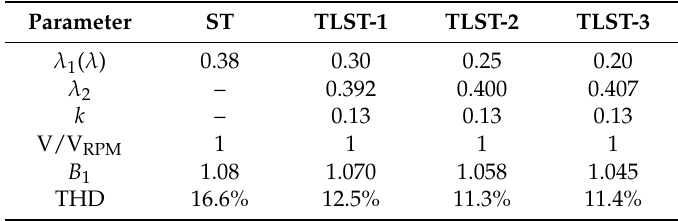
Table 1. B 1 comparison at the same volume.